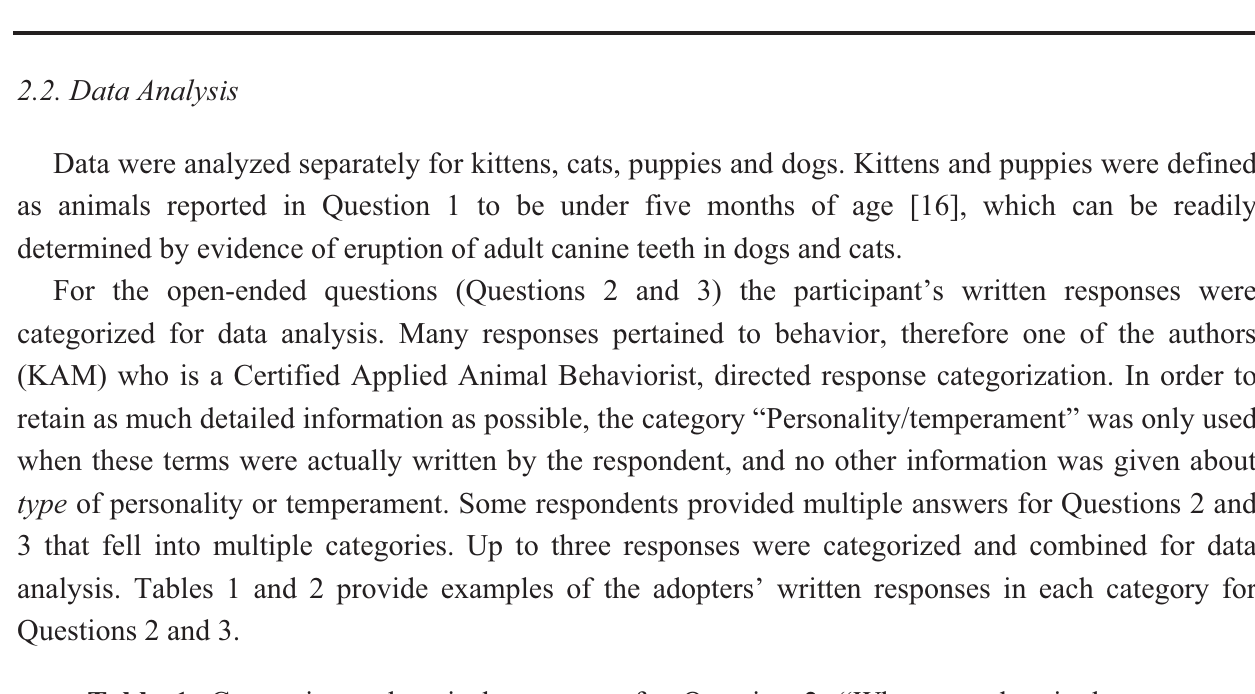
Table 1. Categories and typical responses for Question 2, “What was the single most important reason that you chose this particular